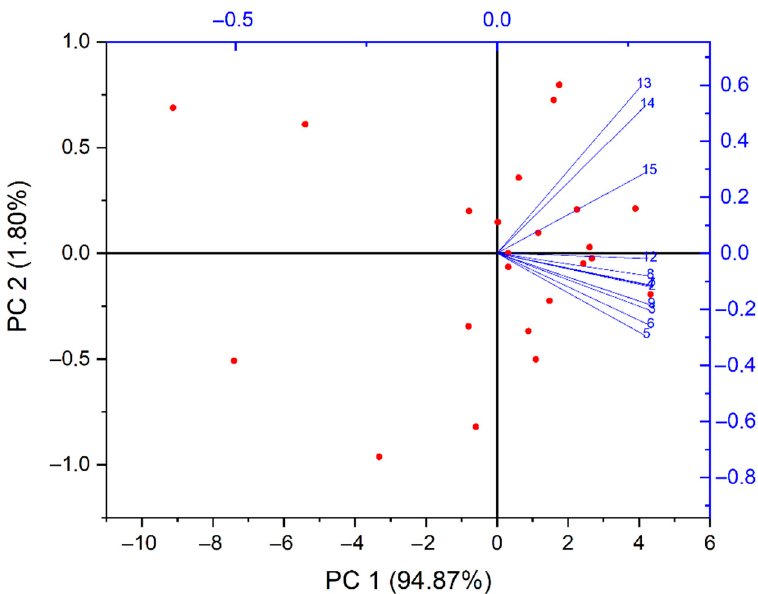
Figure 7. Statistical analyses for pH —PCA (this research).